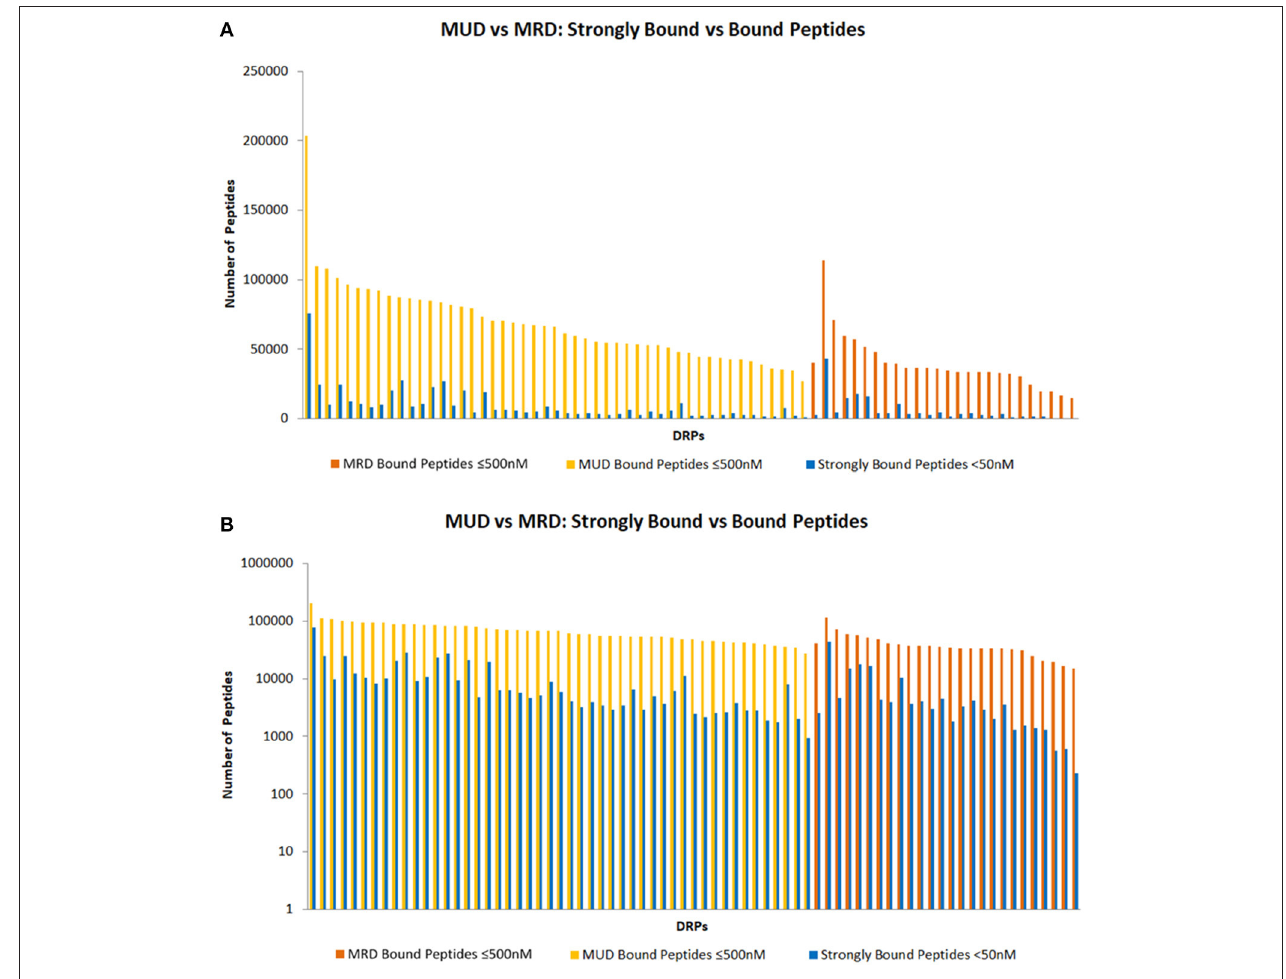
FIGURE 2 | HLA class II bound peptides in HLA MRD and MUD DRP. Depicting SB and BP on standard (A) and logarithmic scales (B)